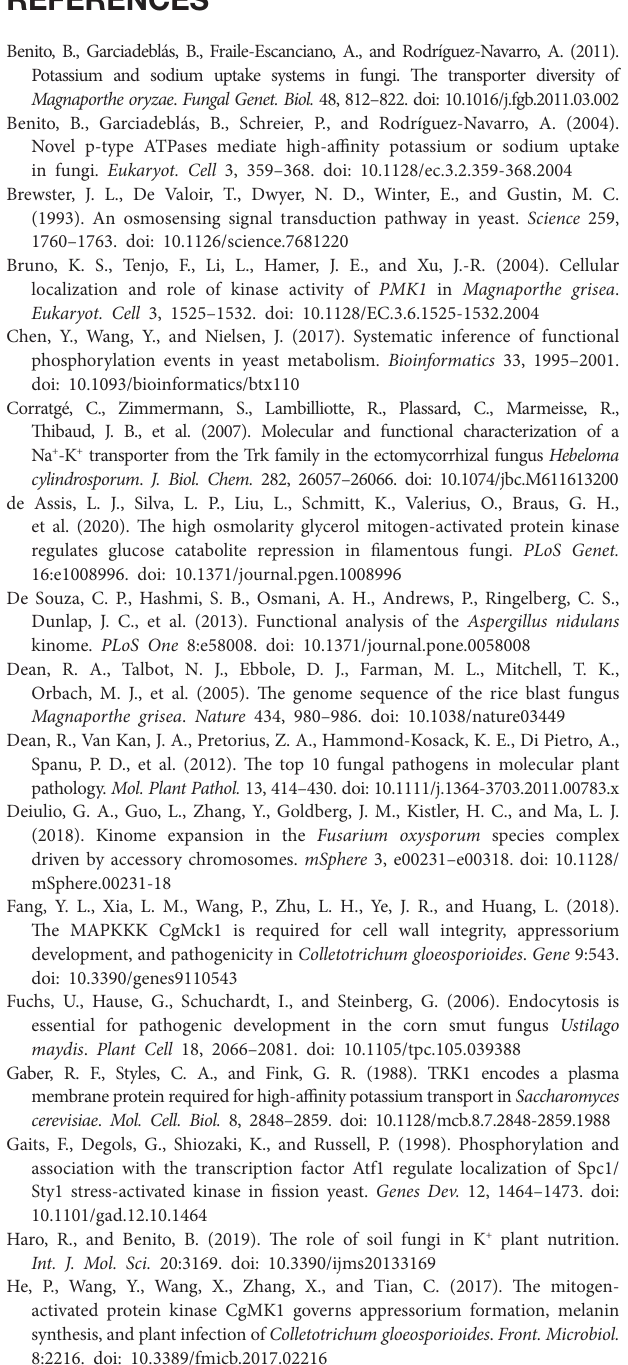
SD-Leu-Trp-His-Ade for 5 days. (C) Phos-tag assay analysis of CgTrk1 phosphorylation. The green fluorescence CgTrk1 (CgTrk1-GFP) fusion protein from the ∆ Cgsat4 mutant cell extracts treated with phosphatase inhibitors were subjected to Phos-tag SDS-PAGE and normal SDS-PAGE followed by immunoblotting with the anti-GFP antibody. The CgTrk1-GFP from wild-type strain cell extracts treated with phosphatase inhibitors or alkaline phosphatase CIP were used as controls. (D) Yeast two hybrid assay for the interaction between CgSat4 and